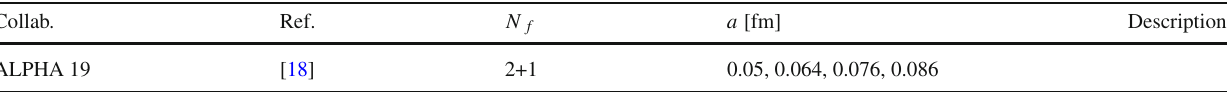
Table 80 Continuum extrapolations/estimation of lattice artifacts in determinations of m ud , m s and, in some cases m u and m d , with N f = 2 + 1 quark flavours Collab. Ref. N f